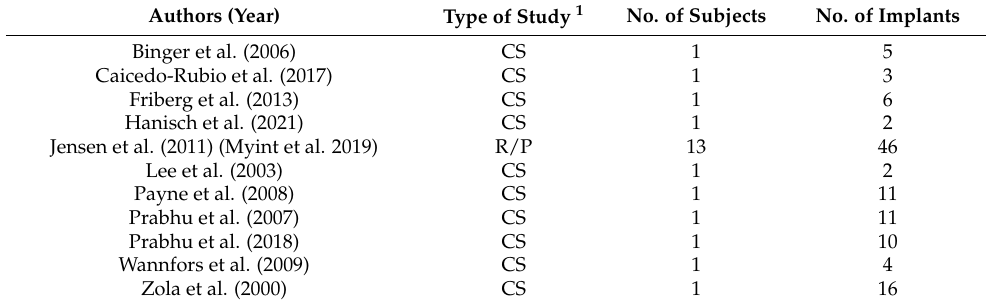
Table 2. Characteristics of the included